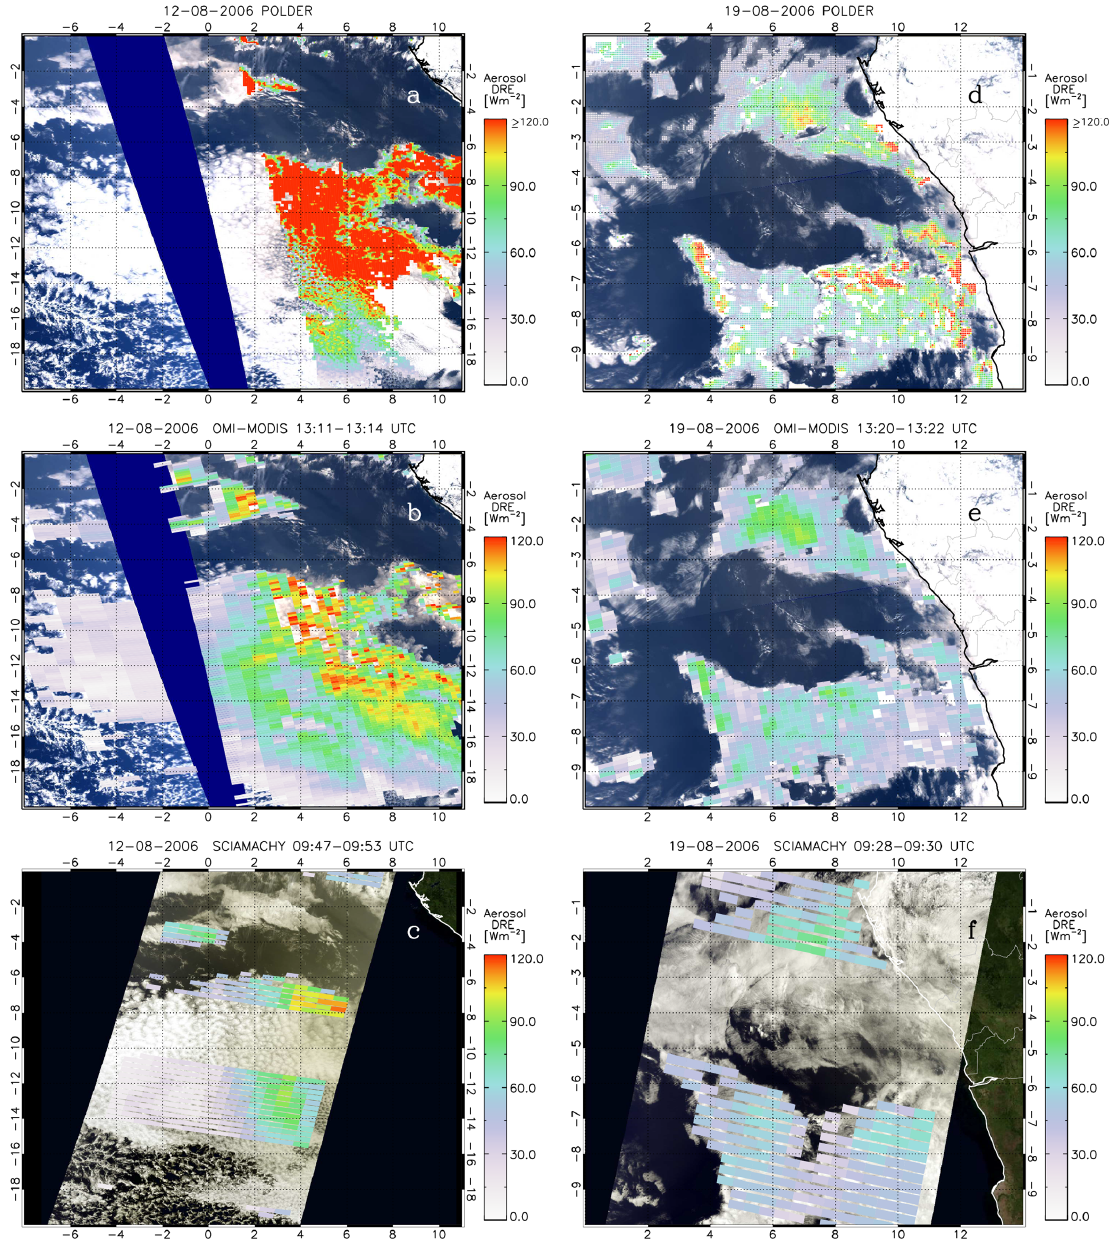
Figure 1. (a) Instantaneous aerosol direct radiative effect (DRE) over clouds on 12 August 2006 from POLDER, overlaid over a MODIS RGB image; (b) aerosol DRE over clouds on the same day from a combination of OMI and MODIS reflectances, overlaid over the same MODIS RGB image; (c) aerosol DRE over clouds from SCIAMACHY on the same day, overlaid over a MERIS RGB image; (d–f) same as (a–c) for 19 August 2006. The areas are centred over the MERIS and SCIAMACHY